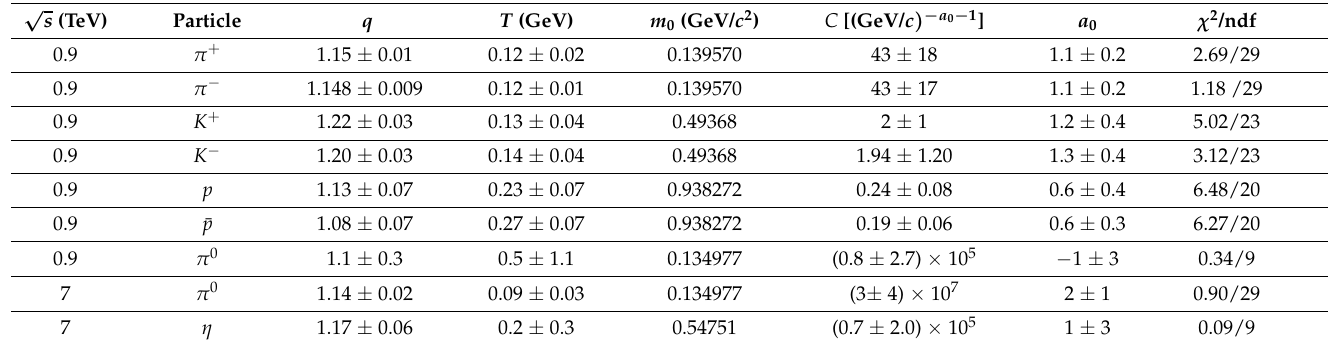
Table 3. Best-fit parameters of the Tsallis–Pareto Formula (3), where the parameter a o is adjustable. For details, see Table 1.